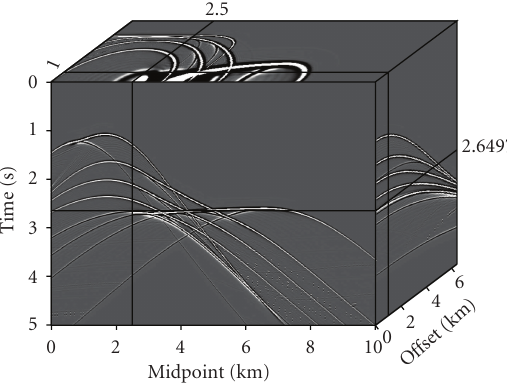
Figure 2: The impulse response for the prestack DTI phase-shift migration of 5 pulses at zero o ff set in a vertically inhomogeneous DTI model with v ( z ) = 1 . 5 + 0 . 6 z km/s and η = 0 . 2 and δ = 0. The three sections represent slices in the prestack cube with the black lines representing the location of these slices relative to each other. As a result, the section on the right is simply the angle gather at distance 4km.